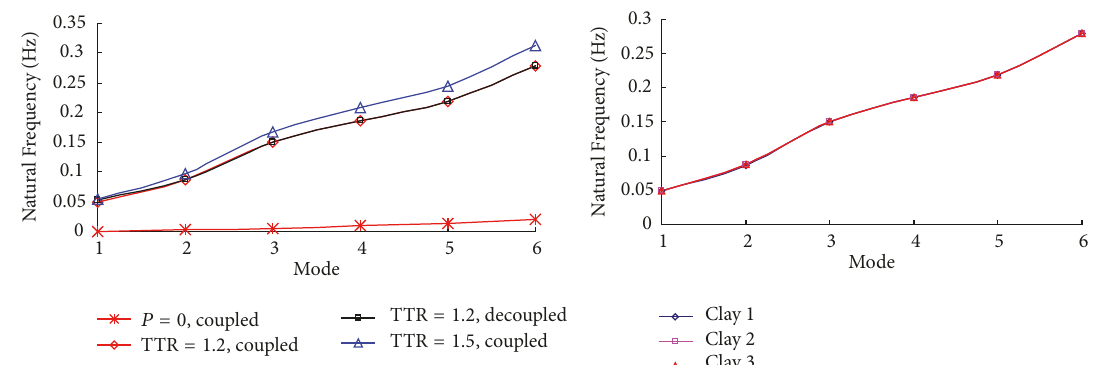
Figure 5: Mode shapes and natural frequency with variable TTR and soil